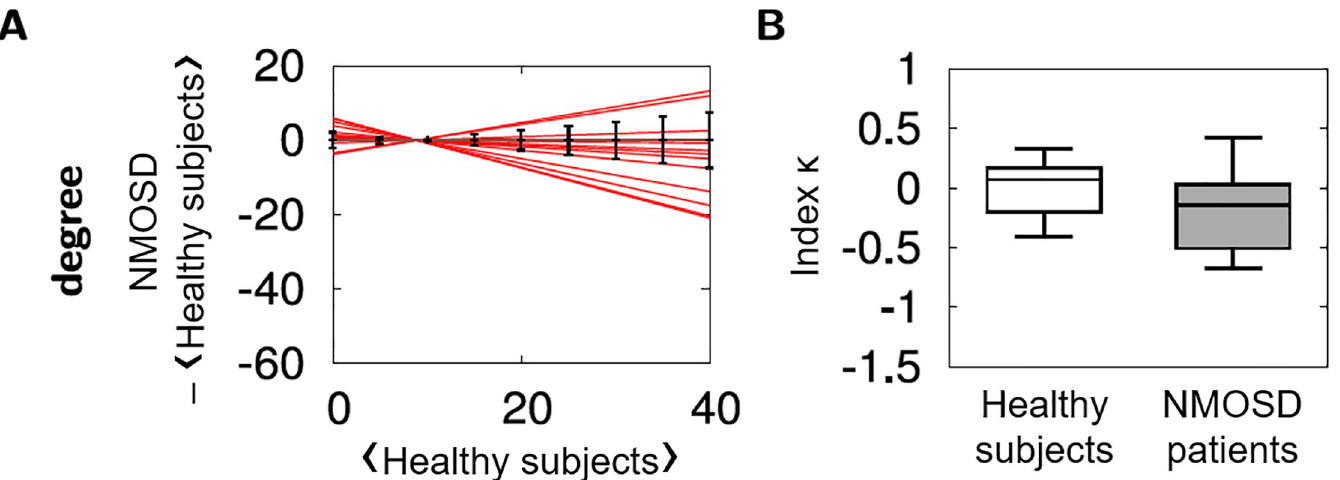
Fig 3. Comparison of nodal degree and hub disruption index κ between NMOSD patients and healthy subjects. (A) Estimated linear regression for each NMOSD patients (red lines) computed from a scatterplot of the nodal degree in an individual participant minus the same nodal property on average over all of the healthy volunteers versus the mean nodal property in the healthy group. Error bars in black reflect standard deviation calculated from the nodal degree in healthy subjects. (B) Boxplots of hub disruption index κ in the control group (white) and the NMOSD group (grey). There was no difference between the two groups.